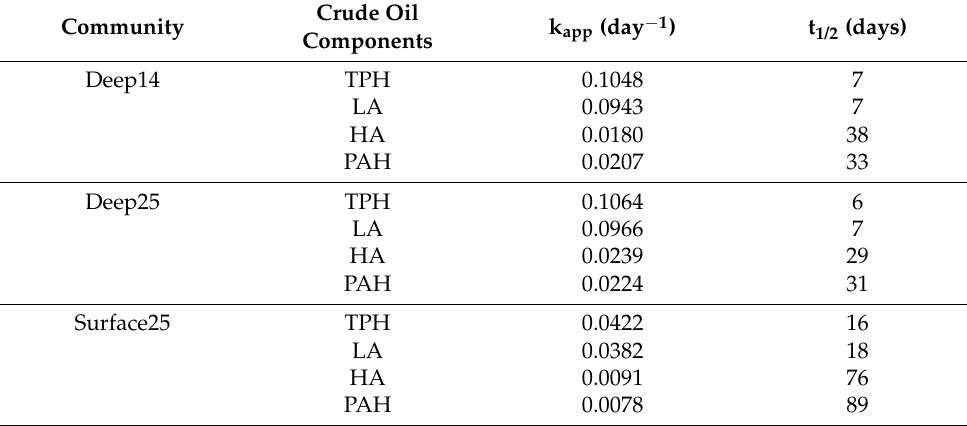
Table 1. Initial rates and half-life times for total petroleum hydrocarbon (TPH), light alkanes (C 14 -C 25 ) (LA), heavy alkanes (C 26 -C 35 ) (HA) and polycyclic aromatic hydrocarbons (PAH) in the Deep14, Deep25 and Surface25 treatments. Crude Oil k app (day − 1 ) t 1/2 (days) Community Components Deep14 TPH 0.1048 7 LA 0.0943 7 HA 0.0180 38 PAH 0.0207 33 Deep25 TPH 0.1064 6 LA 0.0966 7 HA 0.0239 29 PAH 0.0224 31 Surface25 TPH 0.0422 LA PAH 0.0078